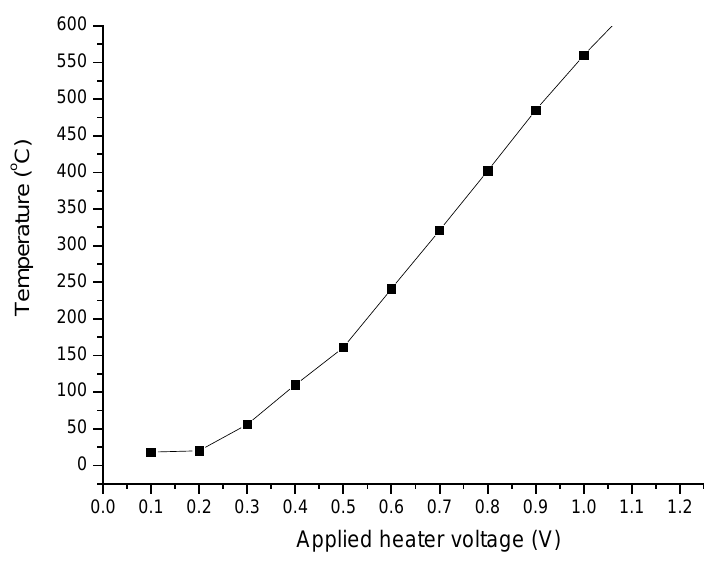
Figure 5. Heater temperature vs. applied heater